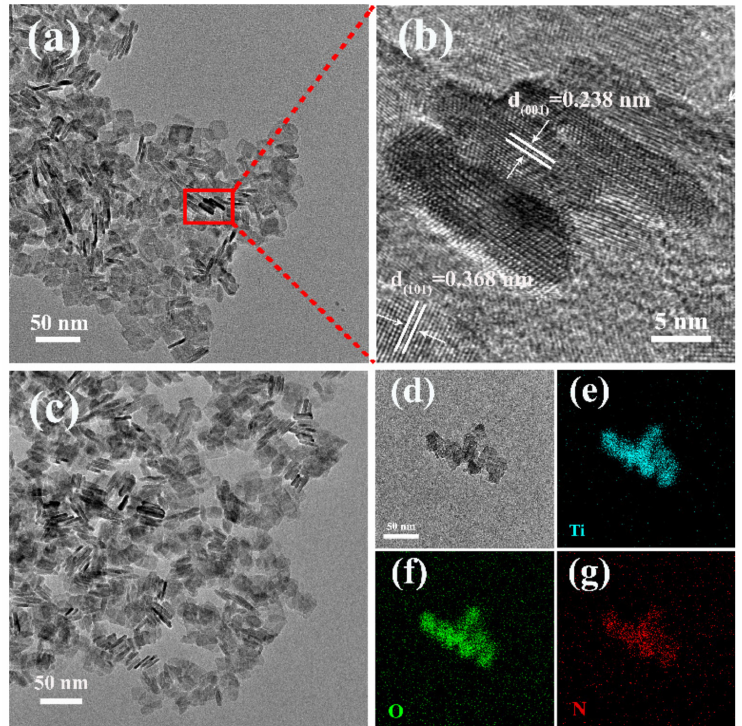
Figure 1. ( a ) TEM and ( b ) HRTEM images of 001T; ( c ) TEM of 8Ppa/001T; ( d ) TEM and ( e – g ) EDS mapping images of the corresponding Ti, O, and N elements of